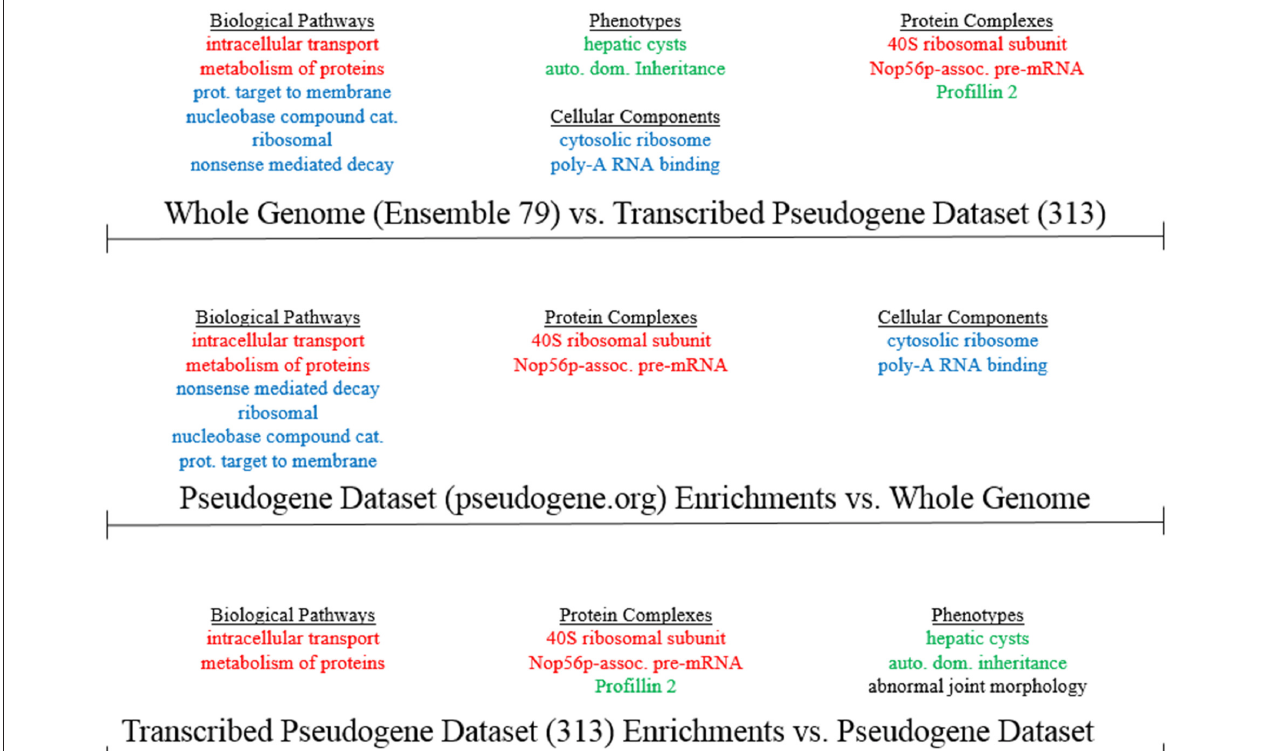
FIGURE 4 | Gene Ontology Comparison of all human protein-coding genes Ensembl 79, the PsiCube pseudogene parental gene database (from pseudogene.org), and the parental genes of the 313 loci computationally identified as bidirectionally-transcribed lncRNA-overlapping pseudogenes. Enrichments which are common to the 313 loci vs. both the whole genome and the parental gene database are in green. Enrichments found in all three comparisons are in red, and those which are unique to either pseudogene parental gene database when compared with the whole genome are in